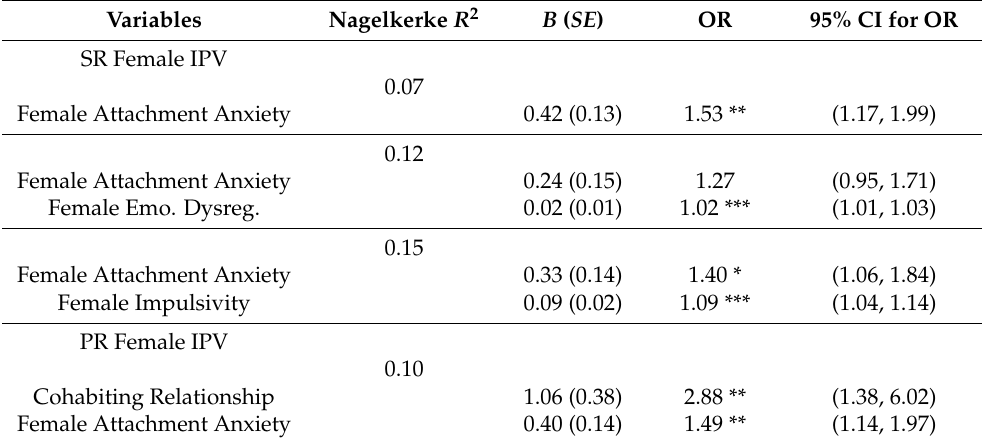
Table 9. Binary logistic regression models: predictors of self-reported and partner-reported female physical